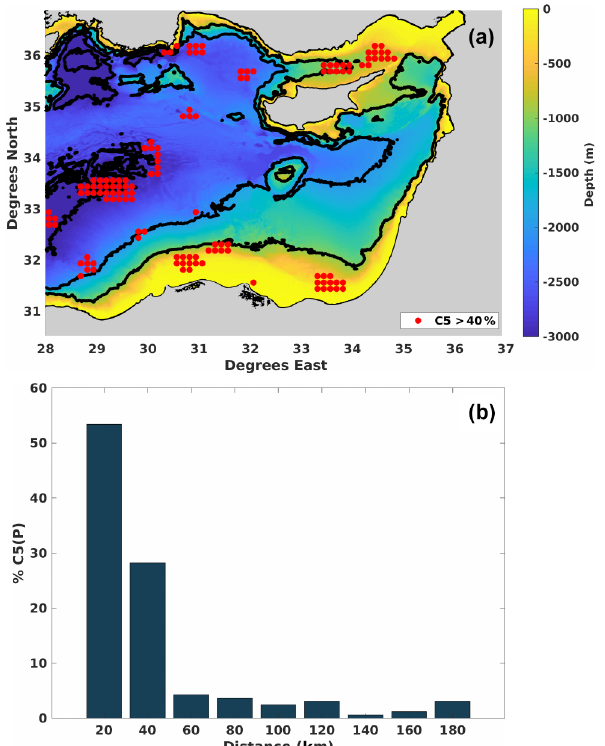
Figure 9. (a) The red dots show the positions of C5P, which are the pixels where C5 existed more than 40% of the time. The dark line represents the main bathymetric iso-lines (1000, 2000, and 3000m). (b) The variations of C5P frequency compared to their closest dis- tance with these iso-lines.